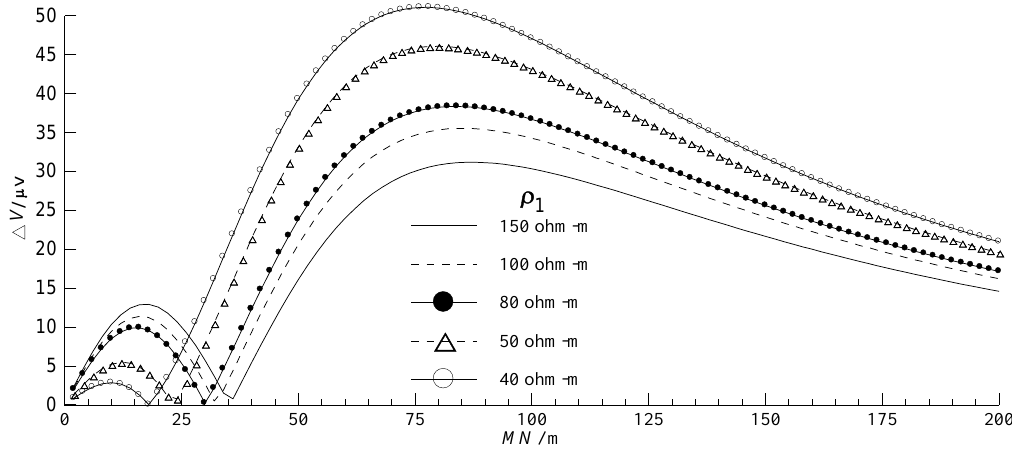
Figure 6. Forward calculating curves of FSM sounding for different resistivity ρ 1.